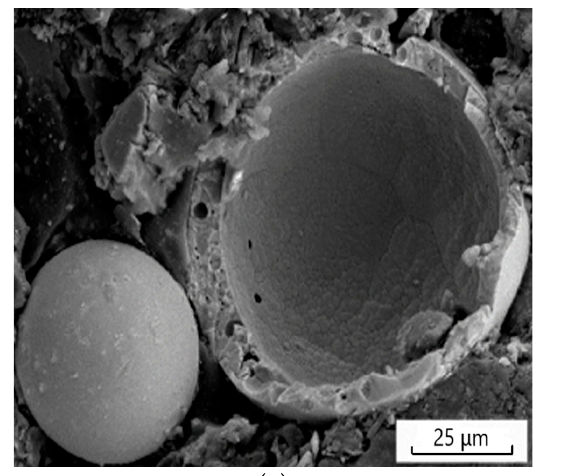
( b ) Figure 3. Microstructure of Amdry 997 powder: ( a ) globular; ( b ) Cross-sectional. 2.2. Thermal Conductivity Simulation According to the real structure of TBCs, the TBC model was divided into four parts including the substrate, the bond coat, the thermally grown oxide and the top coat. To be consistent with the sample’s size of thermal conductivity tested through laser flash heat- ing method, the diameter of the substrate was set as 12.6 mm and the thickness was 2.6 mm. The thick-nesses of the bond coat and the top coat were 0.1 mm and 0.2 mm, respec- tively. To simulate conveniently, the pores were idealized as spherical. To meet the real size scale in the multi-sized porous TBCs, the pore sizes were proposed to be set as 0.3 μ m, 3 μ m and 30 μ m scales. The multi-sized pores distributed randomly in the top coat in real. While, to simulation simplely and conveniently, the radomly distributed multi- sized pores could be arranged in layers with the same ratio of the each sized pores as the real TBCs as well as the total porosities. The number of the three sized pores were set as 1000, 500, and 100 respectively. The total porosity was calculated to be 5%. The number of pores of different sizes would be adjusted to obtain different porosities according to the real ratio of the three scaled pores in the real multi-sized TBCs. The total porosities could be 5%, 10%, 15% and 20% by adjusting the number of pores at different sizes. The appro- priate simulation model was based on the SEM-images and idealized to simple three di- rectional distribution with the same ratio of each sized pores and total porositiesas the